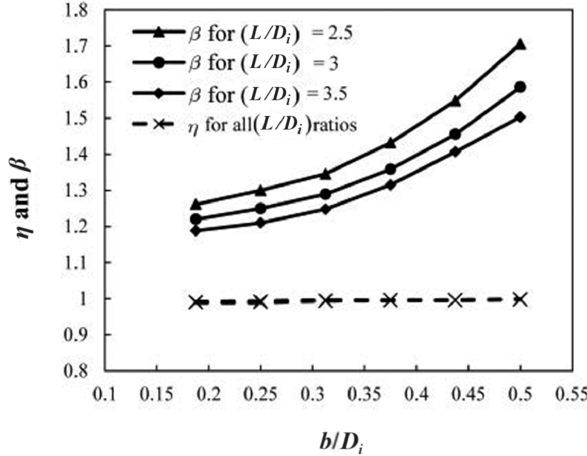
Figure 6: Variations of β and η parameters with various L o / D i ratios; the ratio k / D i for the specimens was 2 for all cases.